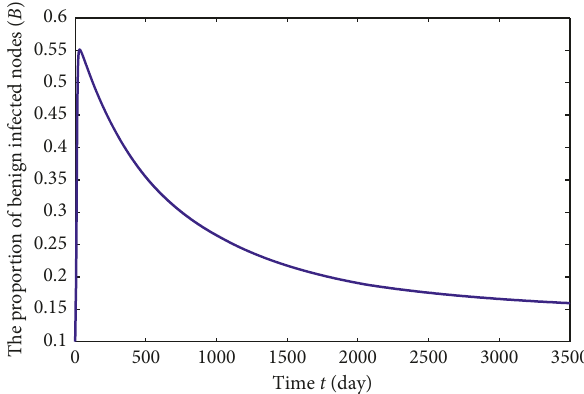
Figure 2: Evolution of B ( t ) for system (5). R